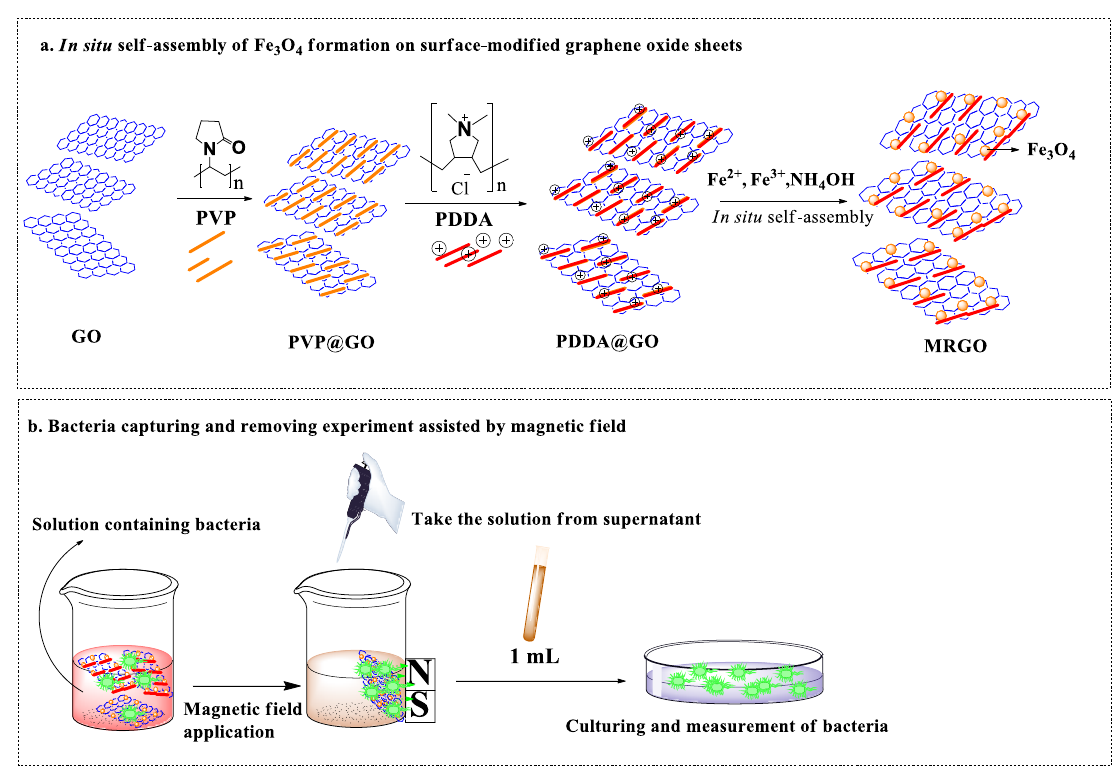
Figure 1. Schematic diagram of ( a ) magnetically reduced graphene oxide (MRGO) preparation and ( b ) bacteria capturing and separation assisted by magnetic